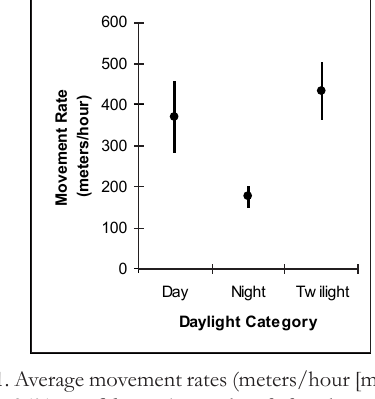
Fig. 1. Average movement rates (meters/hour [m/h]) and 95% confidence intervals of female caribou by daylight categories and season, based on a 1-hour sampling interval, during the winter of 1998–1999, Fortymile Caribou Herd, Alaska.